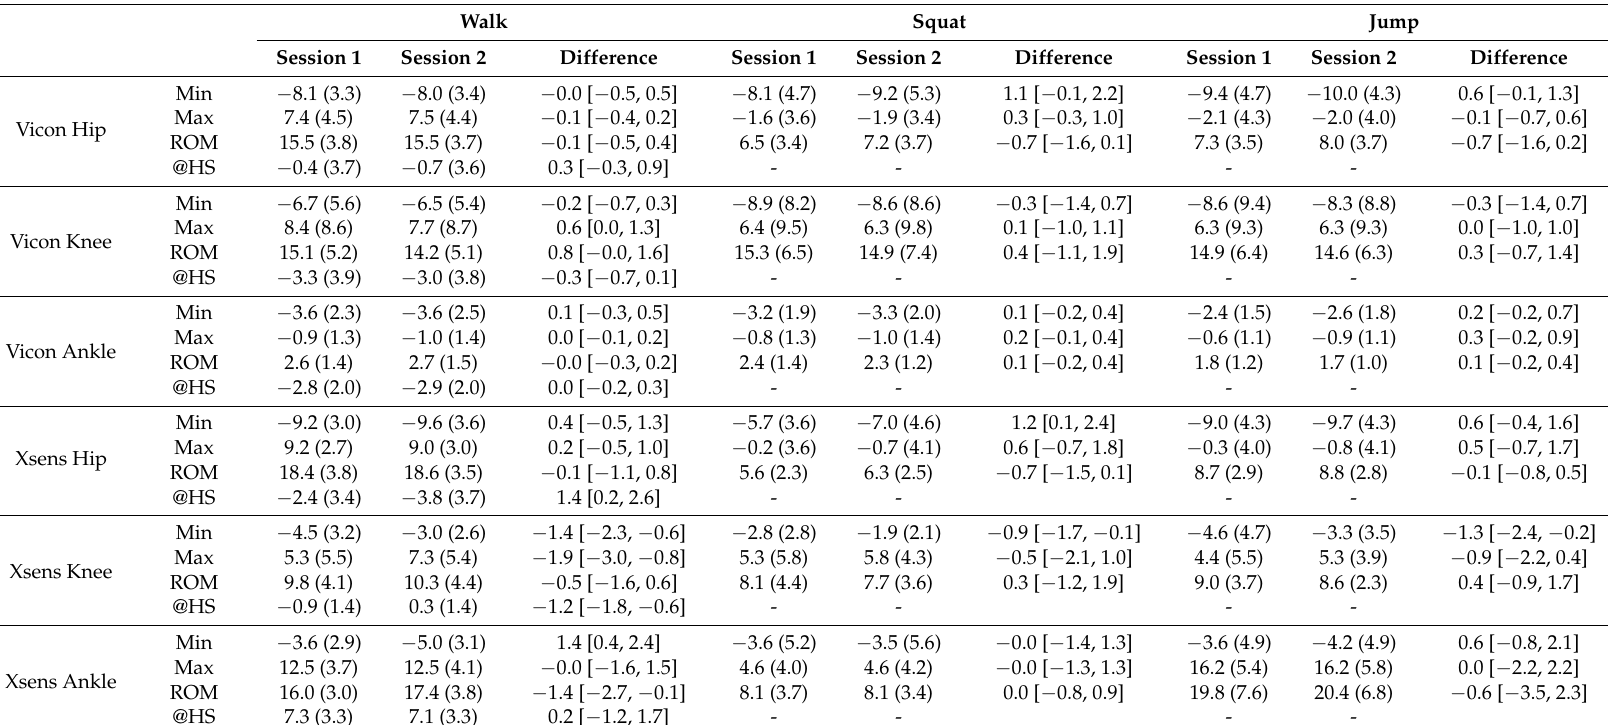
Data for each session are mean (standard deviation). Data for the difference are difference [95% confidence